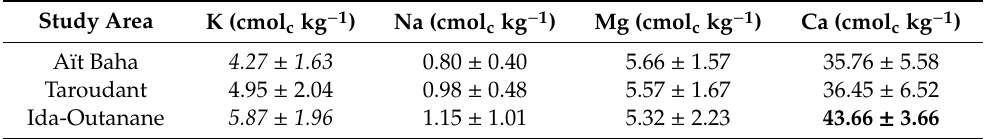
Table 5. Statistical summary of cation concentrations for potassium (K), sodium (Na), magnesium (Mg); and calcium (Ca) for each study area (bold values show significant differences ( p < 0.05) between one study area compared to the other two; italic values show significant differences between two study areas).